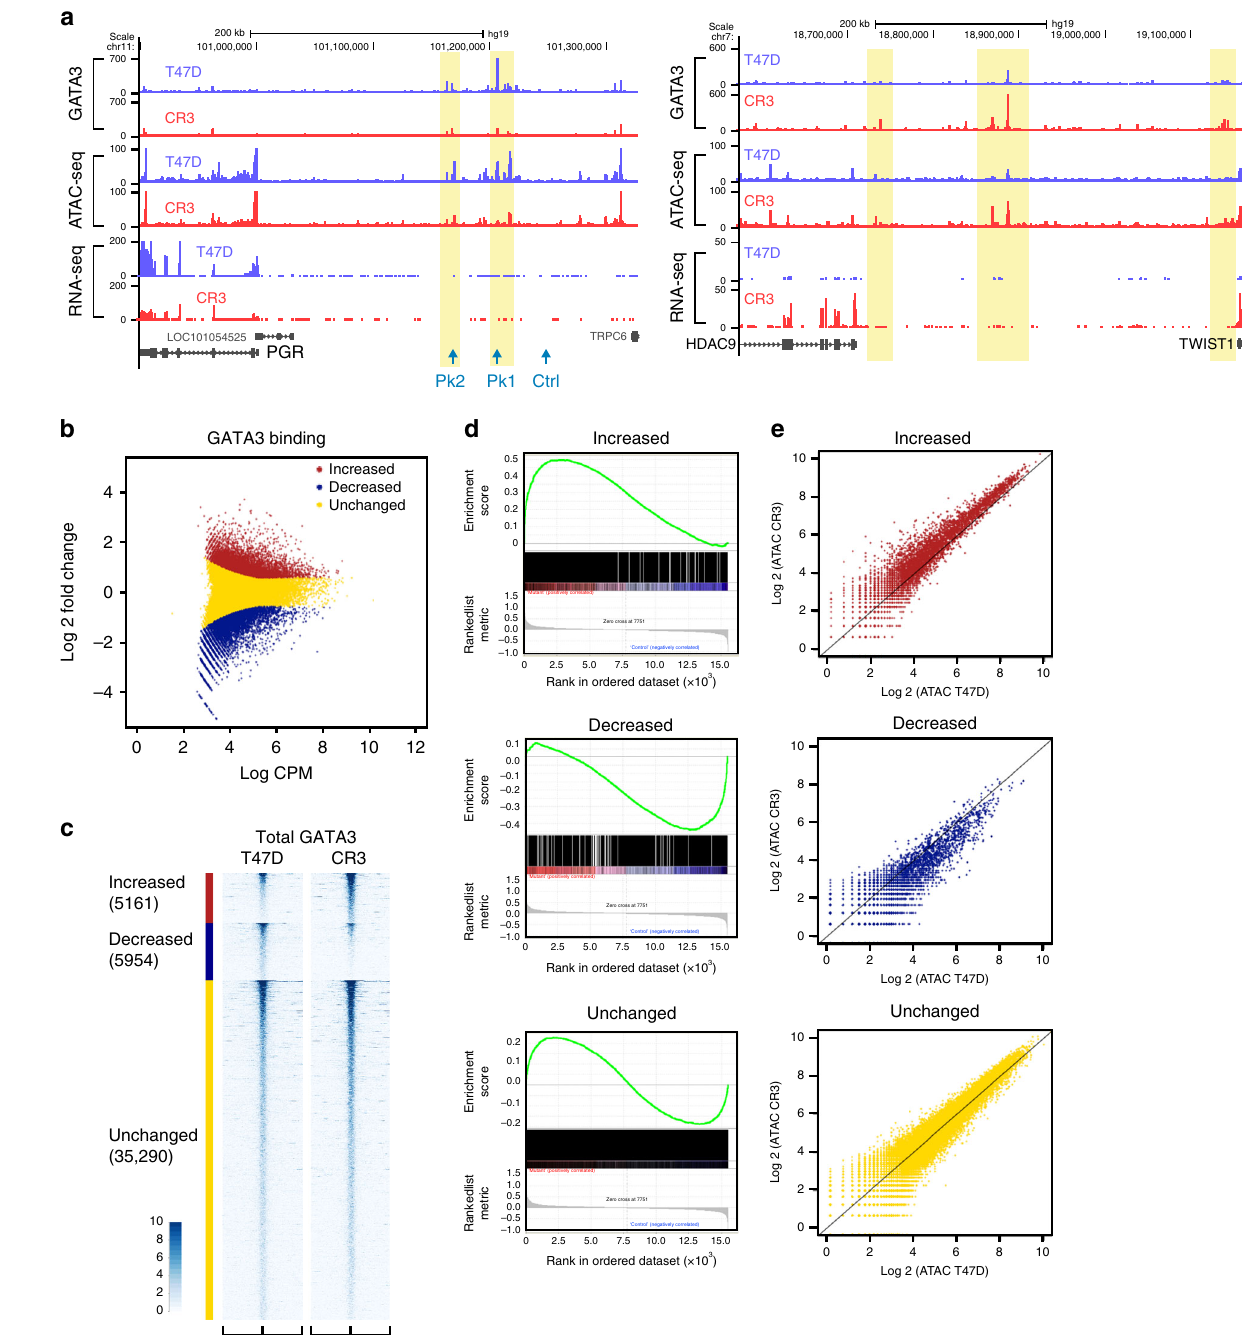
Fig. 4 R330fs GATA3 mutation induces genome-wide relocalization of GATA3. a Representative genome browser tracks at differential GATA3-binding loci. UCSC Genome Browser views showing the mapped read coverage of ChIP-seq, ATAC-seq, and RNA-seq data. The differential-binding sites are highlighted in yellow. The read densities in T47D and CR3 cells are presented in blue and red, respectively. b Differential-binding analysis of GATA3- binding events in control T47D versus CR3 cells. Increased and decreased binding events in CR3 cells are indicated in red and blue, respectively. The conserved-binding events are presented in yellow. CPM indicates counts per million in each peak region. c Read density heatmaps showing the signal intensities of GATA3 ChIP-seq in T47D (left) or CR3 (right) cells. The number of peaks in each category is reported below the group label. Each row indicates a 2 kbp window centered on a GATA3-binding site. The scale of read density after normalization is indicated at the bottom left. d GSEA analysis showing the correlation between each class of GATA3-binding and gene expression. e Scatter plots of normalized ATAC-seq signals in each GATA3-peak group. Normalized read counts in CR3 cells ( Y -axis) were plotted against the counts in T47D cells ( X